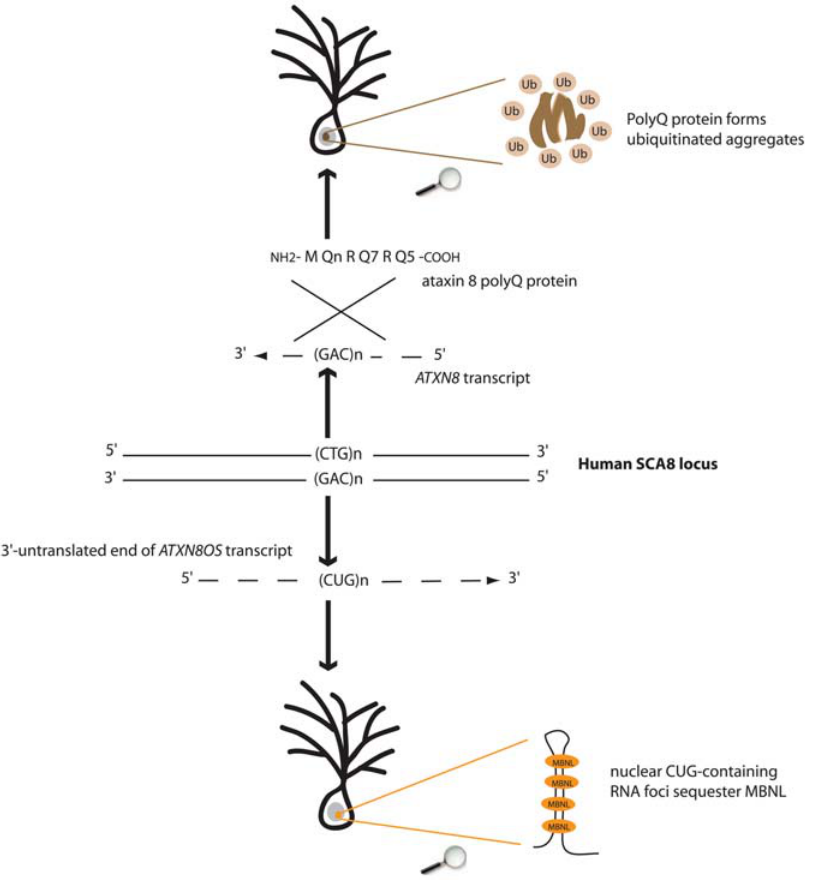
Figure 1. Both toxic-protein (polyQ) and toxic-RNA gain-of-functions might underlie SCA8 pathogenesis. Bidirectional expression of CAG- and CUG-transcripts at the human SCA8 locus results in production of a polyQ protein forming ubiquitinated aggregates and accumulation of RNA foci sequestering MBNL splicing factor.